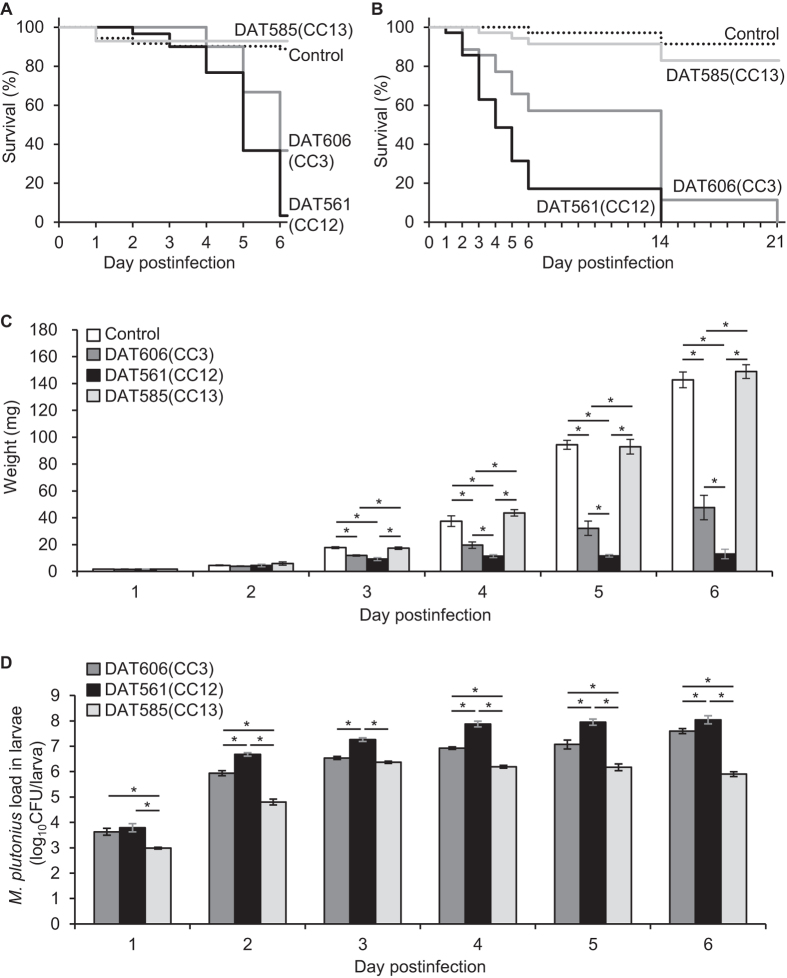
Evaluation of virulence of M. plutonius strains belonging to different CCs under the improved experimental conditions. (A) Survival of control and infected larvae (condition nos 9–12). (B) Survival of control and infected larvae (condition nos 13–16). Larvae in infected groups (nos 10–12 and 14–16) were fed with 10-μl Day 0 diet containing M. plutonius at a final concentration of 2.5 × 105 to 3.6 × 106 CFU/ml (Supplementary Table S1). (C) Larval weight presented as mg (mean ± SEM) (condition nos 13–16). Larvae in infected groups (nos 14–16) were fed with 10-μl Day 0 diet containing M. plutonius at a final concentration of 2.5–5.7 × 105 CFU/ml (Supplementary Table S1). Four to six larvae were randomly selected from each group daily and weighed. The larvae were also used for determination of bacterial loads in the larvae. Asterisks indicate a significant difference (two-tailed Student t-test, P < 0.05). (D) Bacterial loads in larvae calculated by real-time PCR and presented as log10CFU/larva (mean ± SEM) (condition nos 14–16). Asterisks indicate a significant difference (two-tailed Student t-test, P < 0.05). Total no. of larvae used for each experiment is shown in Supplementary Table S1.